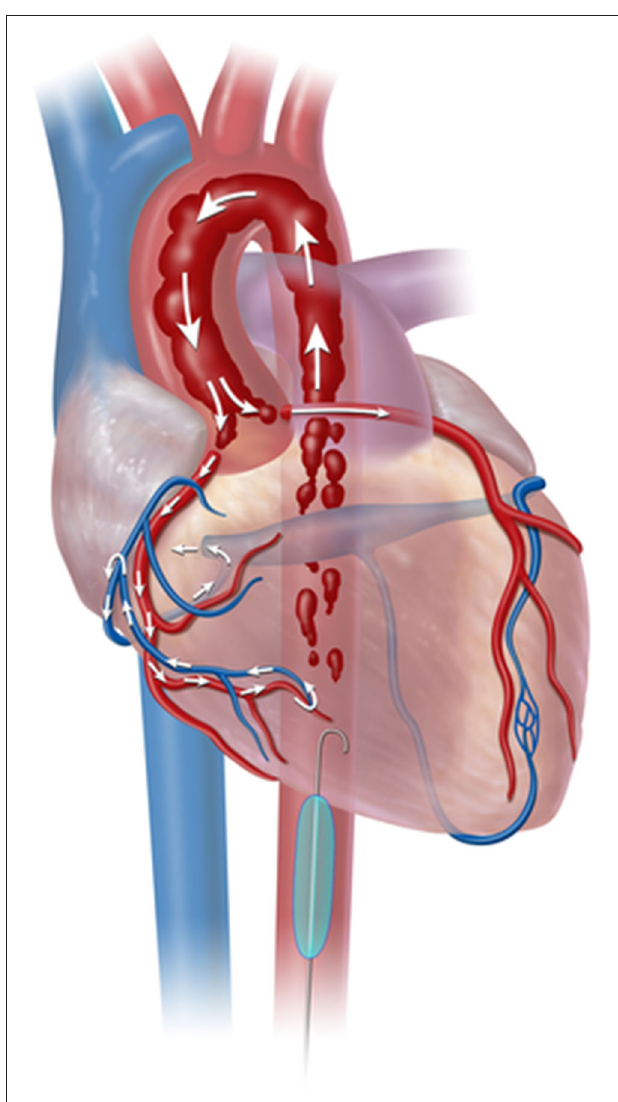
FIGURE 2 | Resuscitative Endovascular Balloon Occlusion of the Aorta (REBOA) deployment in aorta Zone 1. Zone 1 aortic occlusion with REBOA allows the cardiac output generated from cardiopulmonary resuscitation to be directed toward cardiac and cerebral vessels. From Nowadly et al. (14). Copyright © 2020 Reprinted with permission from J Am Coll Emerg Physicians